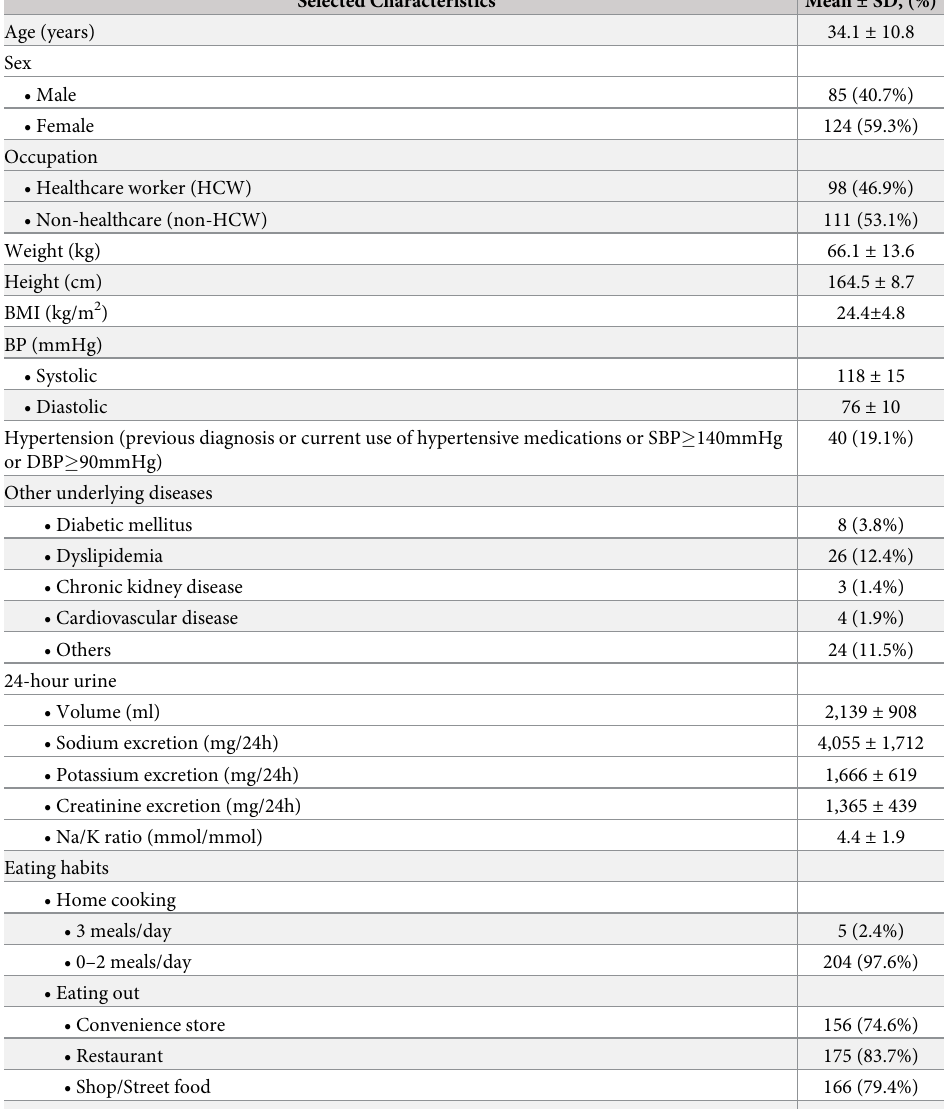
Table 1. Demographic data and clinical characteristic of the study population (N =